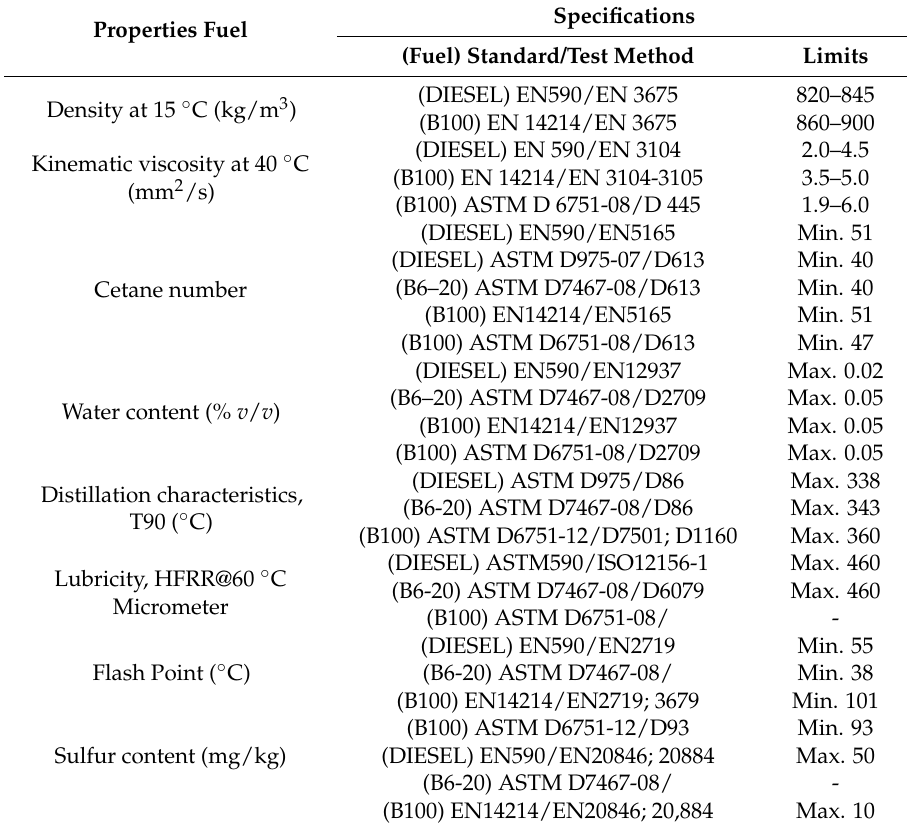
Table 4. Standard Specifications